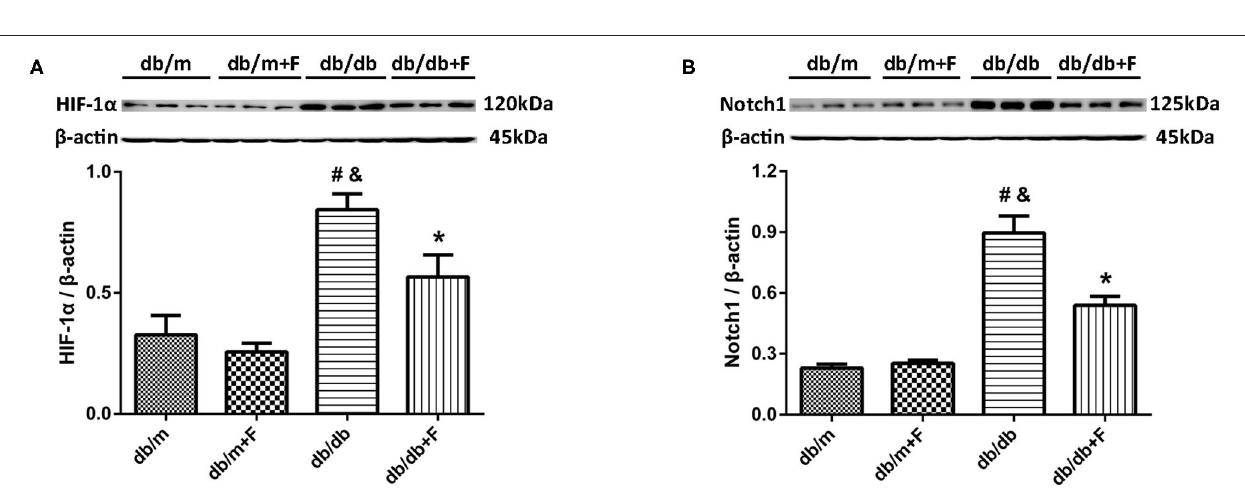
FIGURE 5 | Representative photographs and quantification of reactive oxygen species (ROS) formation in mouse kidneys by dihydroethidium staining. n = 6 mice/group. # P < 0.05 vs. db/m group; & P < 0.05 vs. db/m + F group; * P < 0.05 vs. db/db group. Db/m, db/m mice without fenofibrate treatment; db/m + F, db/m mice with fenofibrate treatment; db/db, db/db mice without fenofibrate treatment; db/db + F, db/db mice with fenofibrate treatment. Data are means ± S.E.M.